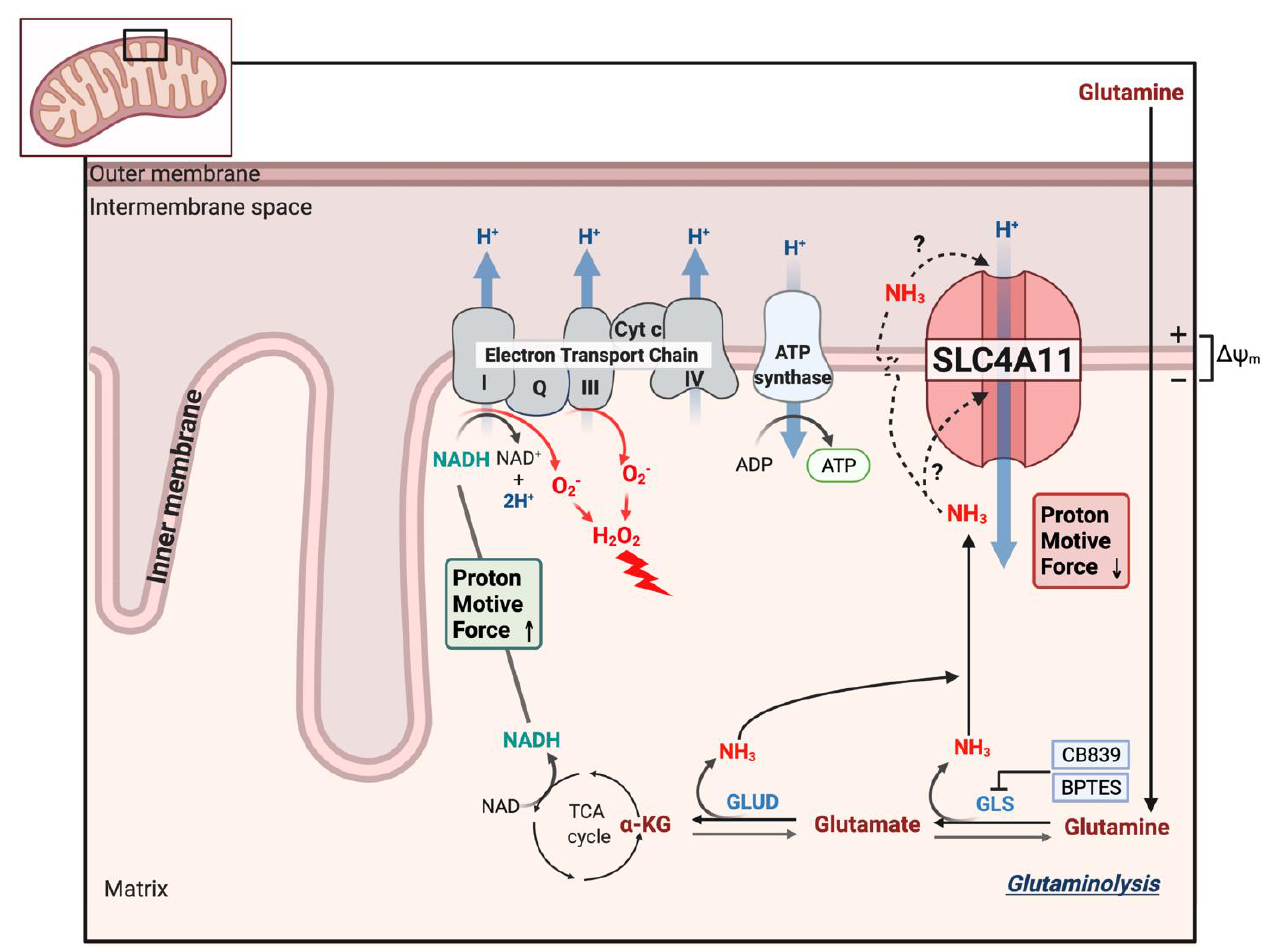
Figure 4. Model of SLC4A11 mitochondrial uncoupling. Glutaminolysis feeds the TCA cycle,